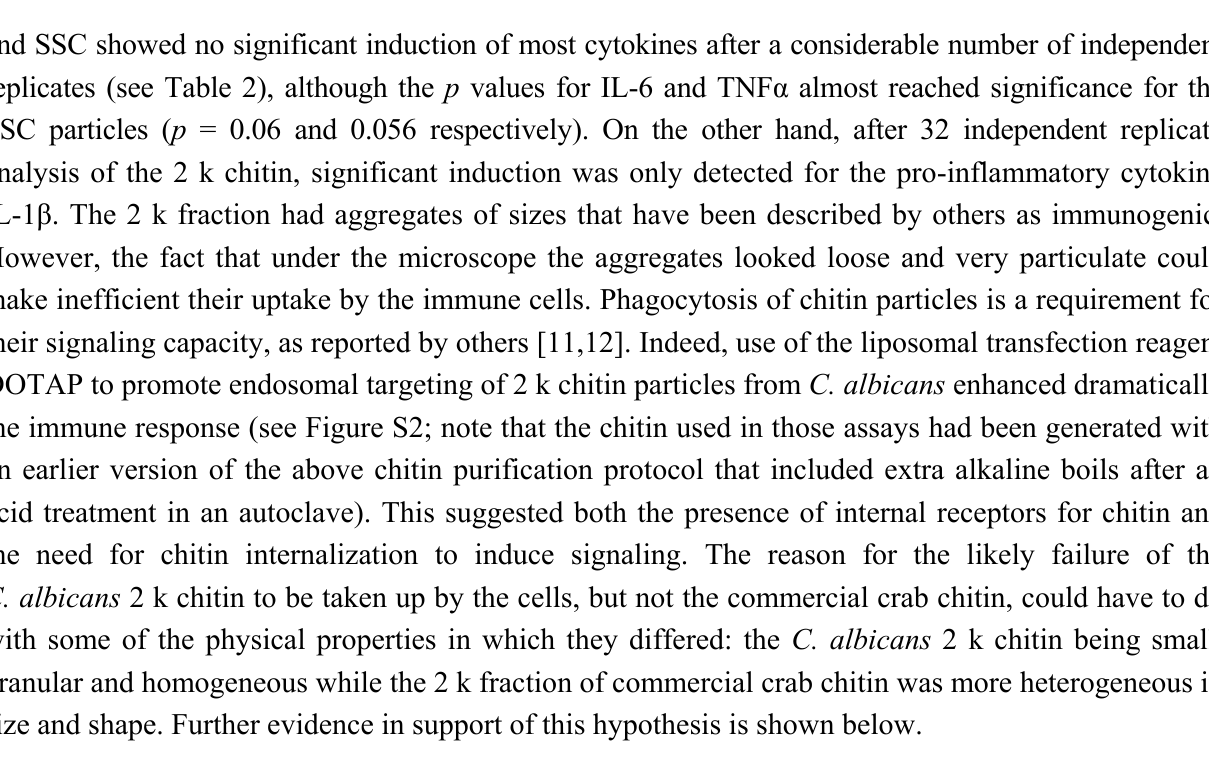
Table 2. Cytokines after exposure of C. albicans yeast chitin to